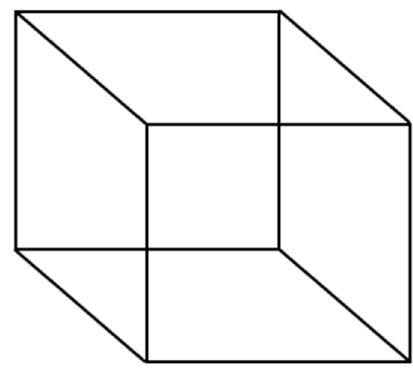
Figure 2. The Necker Cube.